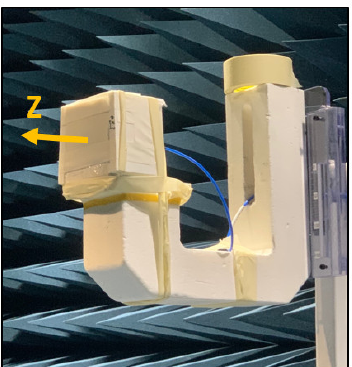
Figure 11. The seven-layer phantom containing the antenna prototype is mounted on the positioner inside the anechoic chamber.